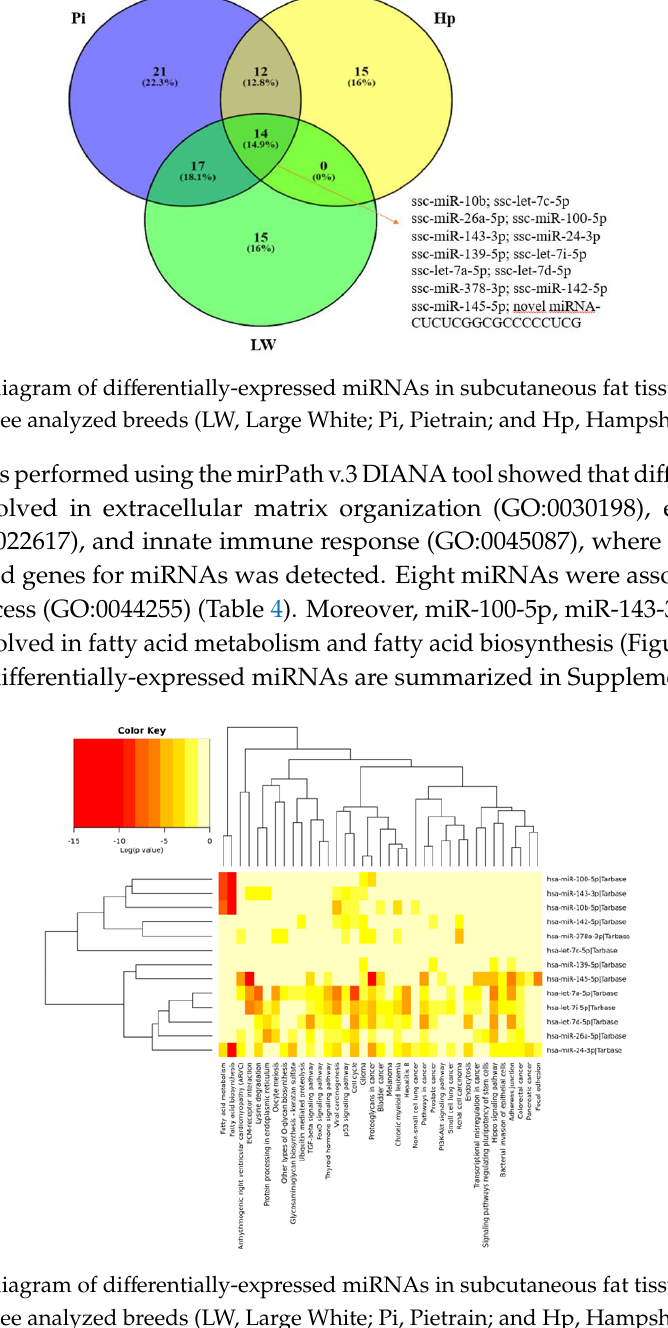
Figure 3. The detected differentially-expressed genes involved in GO terms related to lipid metabolism processes (String software based on Sus scrofa reference; detected genes showed no more than five interactions. Line shape indicates the predicted mode of action: red, interactions that were experimentally determined; blue, interactions from curated databases; black, co-expression; green, text mining associations and interactions based on relevant publications mentioning a transfer from other organisms; yellow, transcriptional regulation).